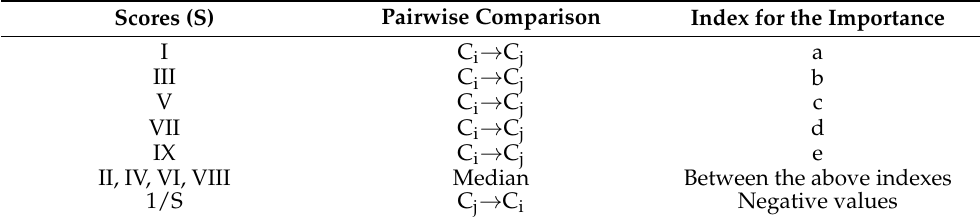
Table 3. The index scale judgment rules.